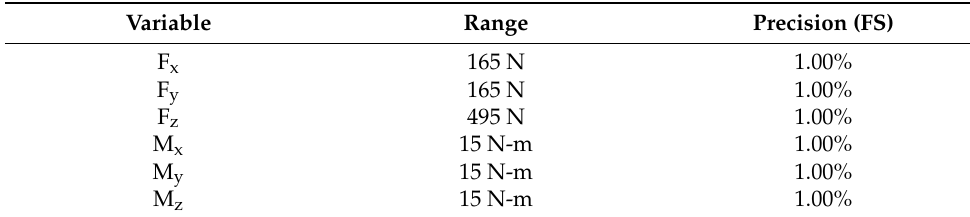
Figure 5. Experimental layout. Table 1. ATI balance